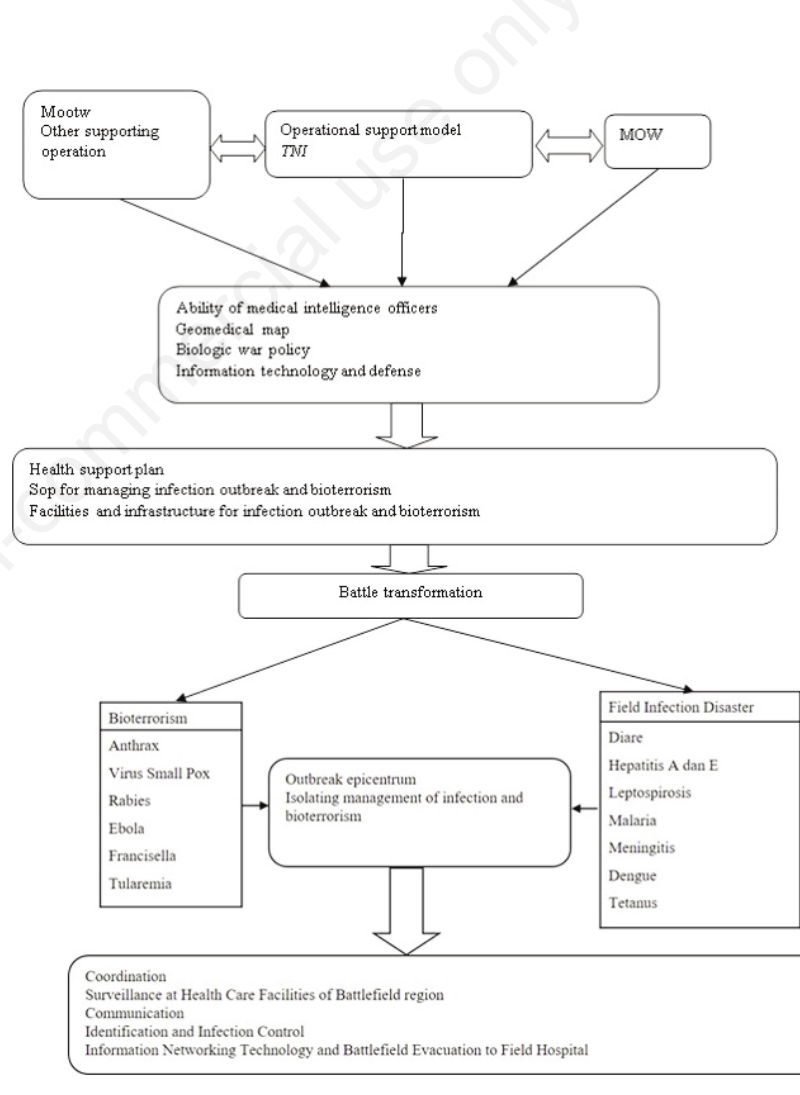
Figure 1. Model for management of infectious disease and bioterrorism in battle trans-